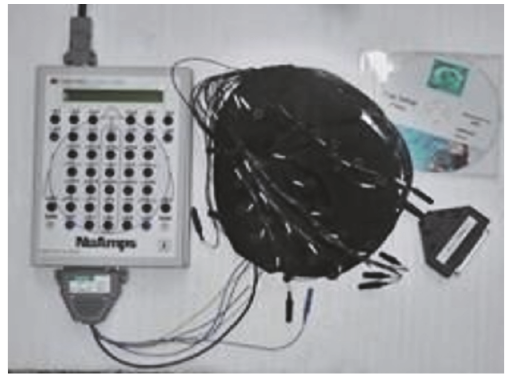
Figure 3: EEG recording